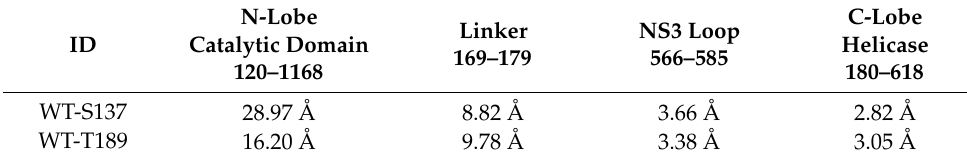
Table 4. RMSD difference from WT of structural and functional